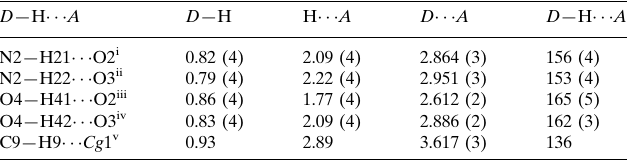
Hydrogen-bond geometry (A˚ , (cid:2)